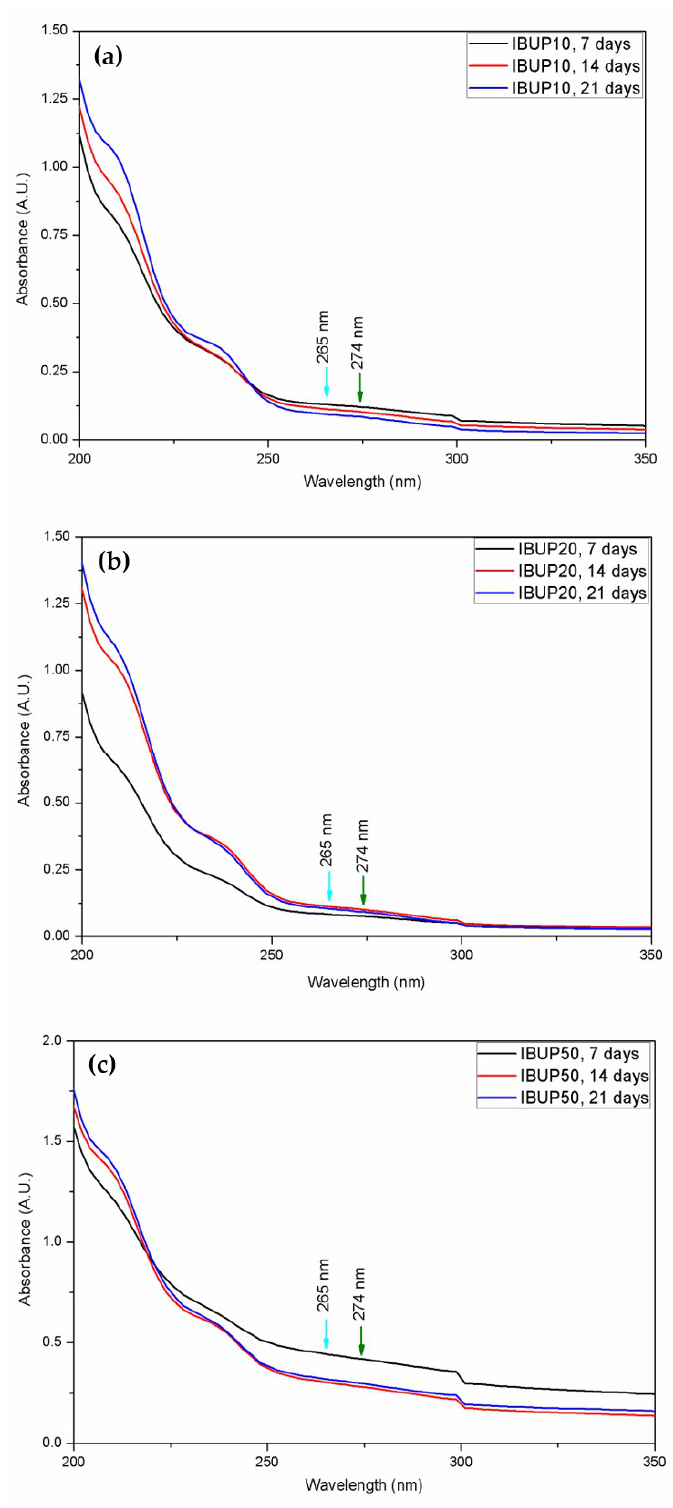
Figure 5. UV-Vis spectra of ( a ) IBUP10, ( b ) IBUP20, and ( c ) IBUP50 biopolymeric spheres after dynamic tests.